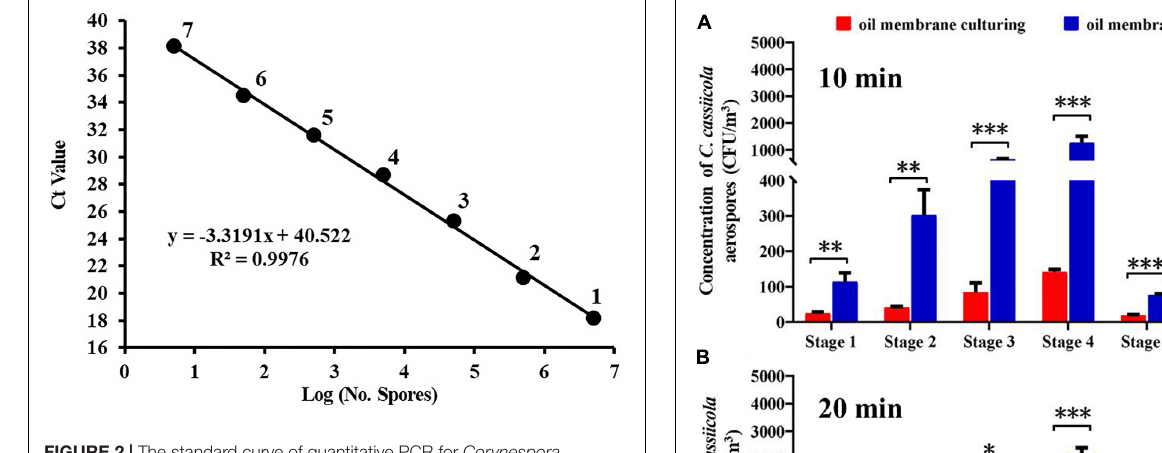
FIGURE 2 | The standard curve of quantitative PCR for Corynespora cassiicola spores. Spores were serially diluted prior to DNA extraction, and the DNA from three replicates was pooled for each point on the standard curve. Ct, cycle threshold. Points are representative of DNA extracted from (1) 5 × 10 6 , (2) 5 × 10 5 , (3) 5 × 10 4 , (4) 5 × 10 3 , (5) 5 × 10 2 , (6) 50, and (7) 5 spores. Efficiency = 100.12%.